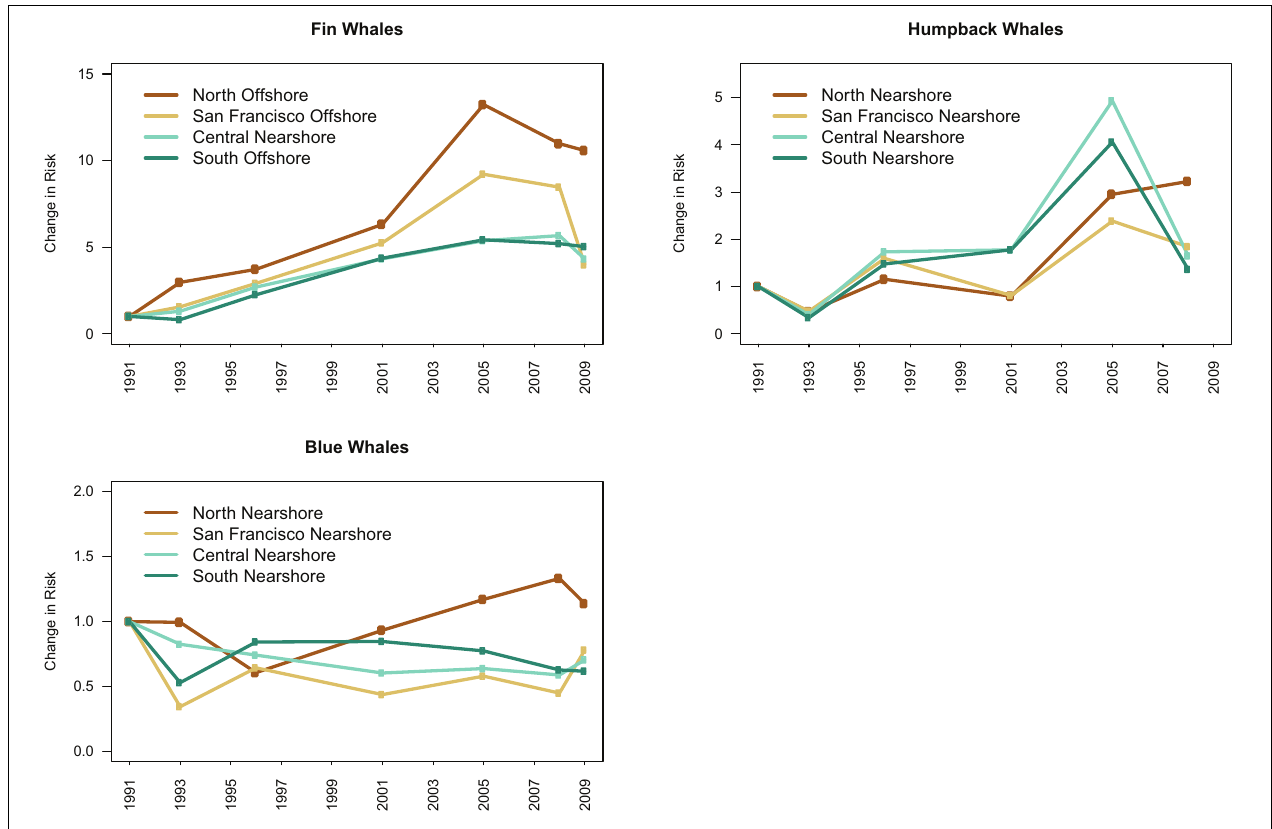
FIGURE 7 | We estimated the change in the total ship-strike risk experienced by each whale population using the ratio of the risk in each survey year to the risk at the start of the survey period (i.e., 1991). We used the risk from the traffic scenario (i.e., nearshore or offshore; see text for details and Figure 3 ) resulting in the highest risk for each species in each region. For humpback and blue whales, the nearshore traffic scenario had the highest risk in all regions. For fin whales, the offshore traffic scenario had the highest risk for all regions except the central region. Risk was highest from the nearshore traffic scenario in the central region for fin whales. The x -axes represent years in which marine mammal surveys were